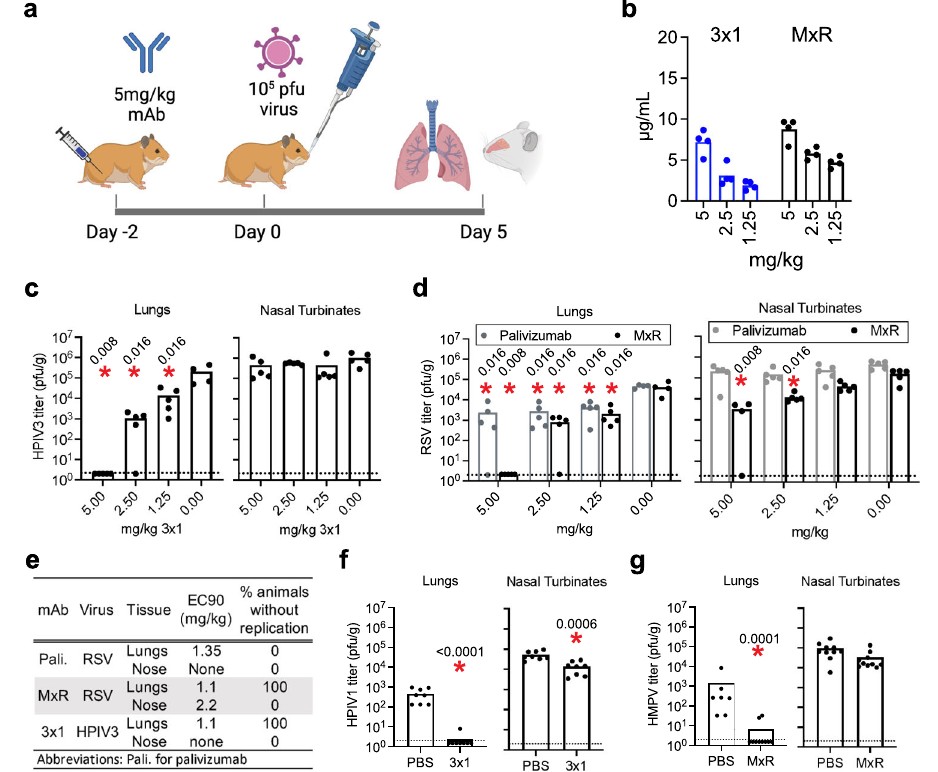
Fig. 5 | Ef fi cacy of prophylactic administration of cross-neutralizing mono- clonal antibodies 3×1 and MxR in vivo. a Schematic of experiments in which hamsters were injected intramuscularly with 3×1 or MxR two days prior to intra- nasal challenge with 10 5 pfu of virus. b Serum concentrations of 3×1 and MxR two days after administration of mAbat5,2.5,and 1.25mg/kg were measured by ELISA ( n =4 animals/dose). Dose – response of 3×1 ( c ) and MxR ( d ) on HPIV3 and RSV replication, respectively ( n =5 experimental animals/dose/virus, n =5 control ani- mal nasal turbinates/virus, and n =4 control animal lungs/virus). e 90% effective concentration(EC 90 )ofpalivizumabagainstRSV,MxRagainstRSV,and3×1against HPIV3 based on dose – response experiments. f HPIV1 and ( g ) HMPV replication